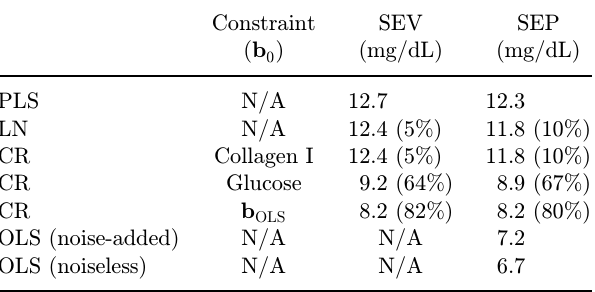
Table 2. Comparison of di®erent calibration methods with simulated data. Column 1 indicates the constraint used, col- umns 2 and 3 list the SEV and the SEP values obtained, with corresponding error reduction compared to PLS in parentheses, using the OLS (noise-added) and SEP (7.2) as the best achievable values. OLS (noiseless) indicates OLS in the absence of spectral noise; OLS (noise-added) denotes OLS with the same amount of spectral noise as for the PLS/CR data. Both OLS results include the same amount of concentration error as for PLS/CR data.